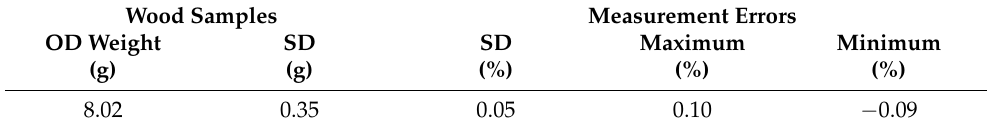
Table 5. Average oven-dried weight (OD), standard deviation (SD) and random measurement error. Wood